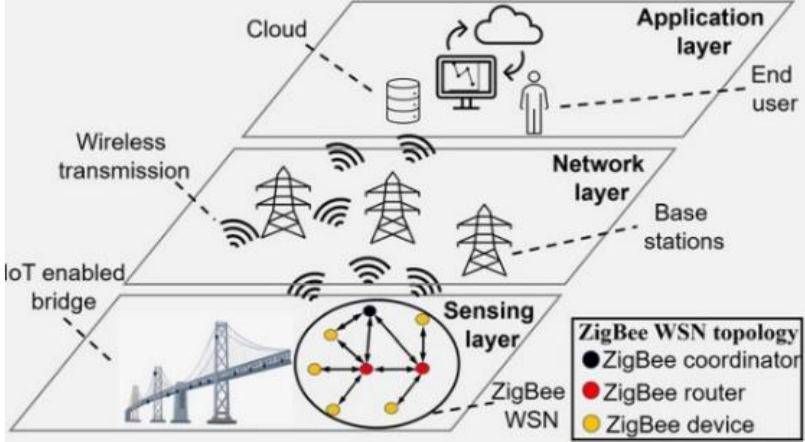
Figure 2. IoT enabled bridge case